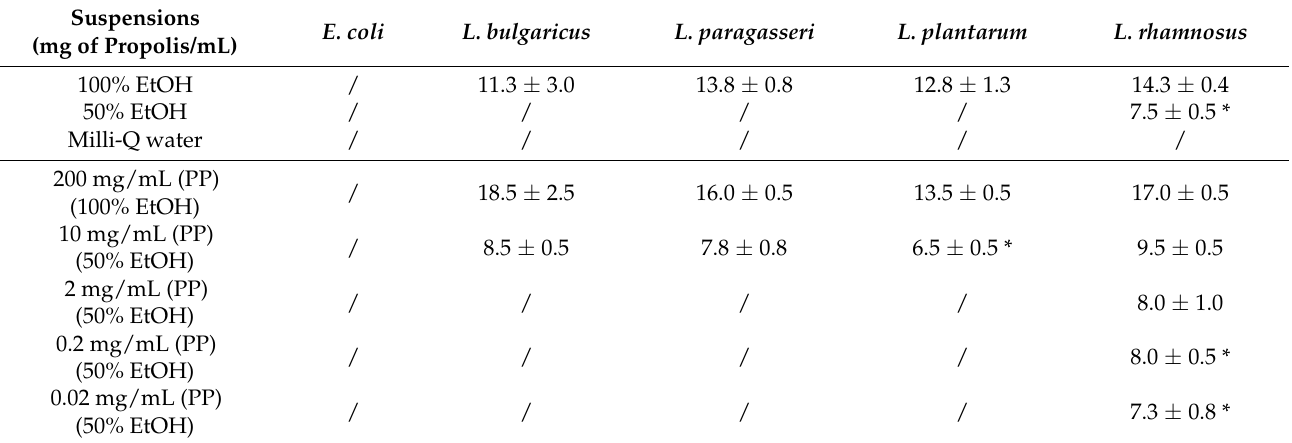
Table 1. Antimicrobial activity of solutions containing different amounts of propolis extract (in EtOH) expressed as inhibition zone radiuses, based on the agar disc diffusion test with addition of 10 µ L solution/6 mm